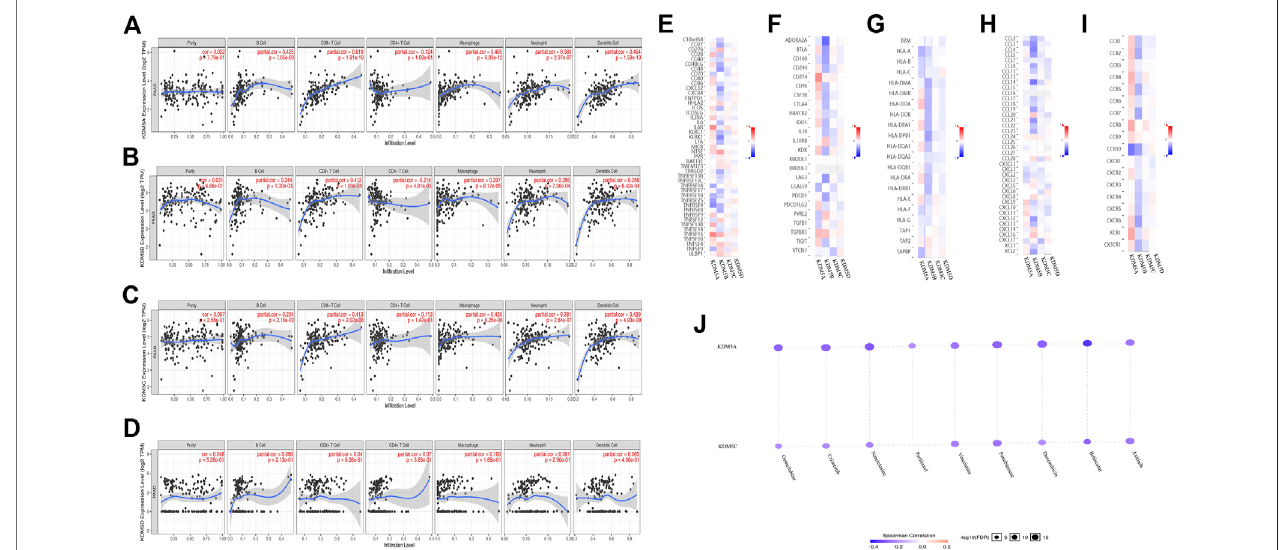
FIGURE 7 | Relationships between the expression levels of KDM5 family members and tumor-in fi ltrating immune cells, immune molecules, and sensitivity to pancreaticcancer-targetingandchemotherapeuticdrugs. (A – C) UpregulationofKDM5A/B/Cexpressionisassociatedwithincreasedin fi ltrationofBcells,CD8 + Tcells, macrophages, neutrophils, dendritic cells, and other in fi ltrating lymphocytes; (D) Upregulation of KDM5D expression is not associated with increased in fi ltration of B cells, CD8 + T cells, macrophages, neutrophils, dendritic cells and other in fi ltrating lymphocytes; (E – I) The correlation between KDM5 family expression and immunostimulatorymolecules,immunosuppressivemolecules,MHCmolecule,chemokines,andchemokinereceptorsinpancreaticcancer; (J) Theexpressionlevelsof KDM5A and KDM5C are negatively correlated with sensitivity to many pancreatic cancer-targeting and chemotherapeutic drugs, including axitinib, and